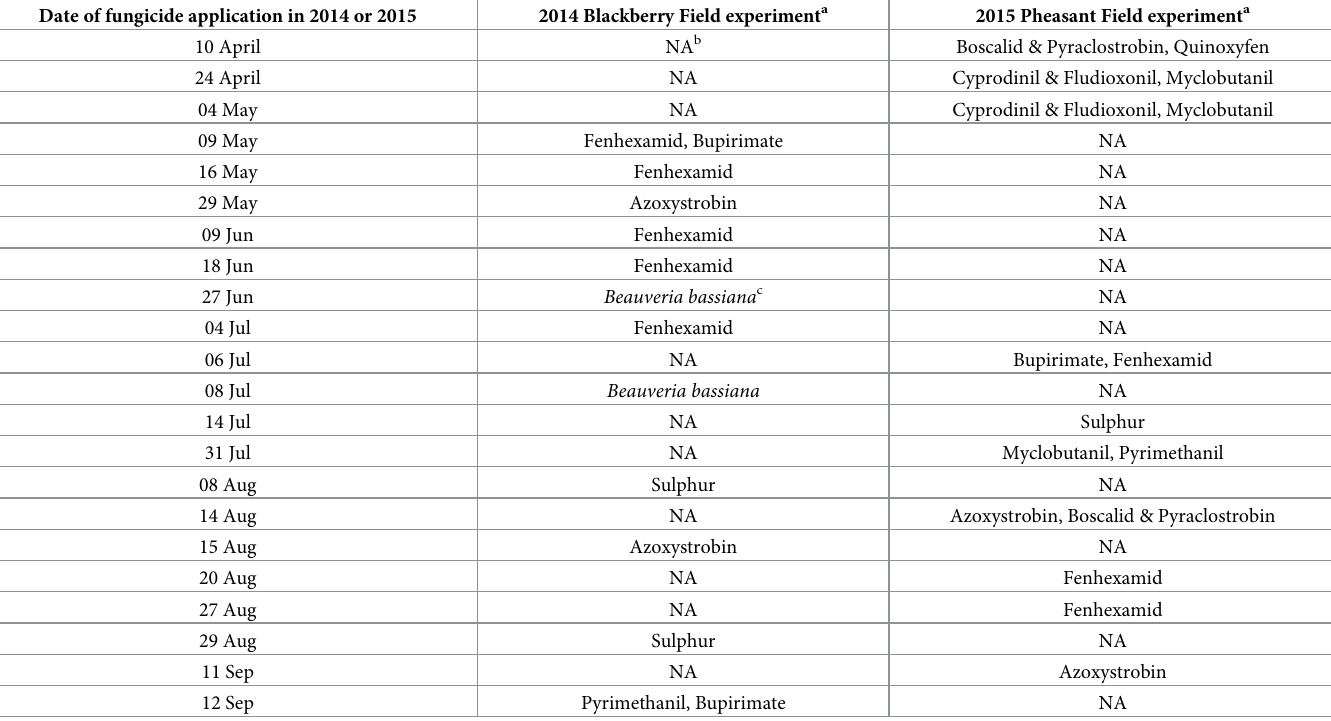
Table 1. Fungicide/biocontrol agent applications following the farm commercial spray schedules in the 2014 and 2015 silicon fertigation experiments. Date of fungicide application in 2014 or